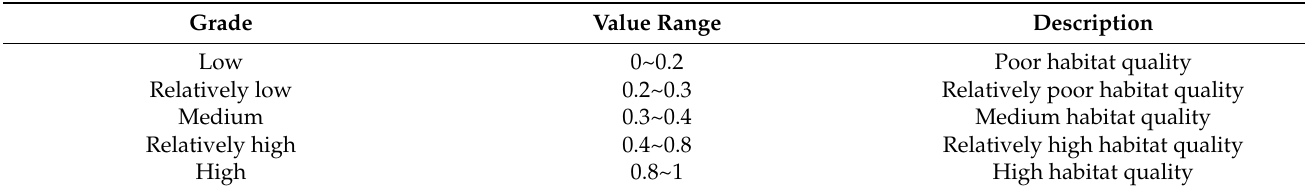
Table 4. Classification value of habitat quality.